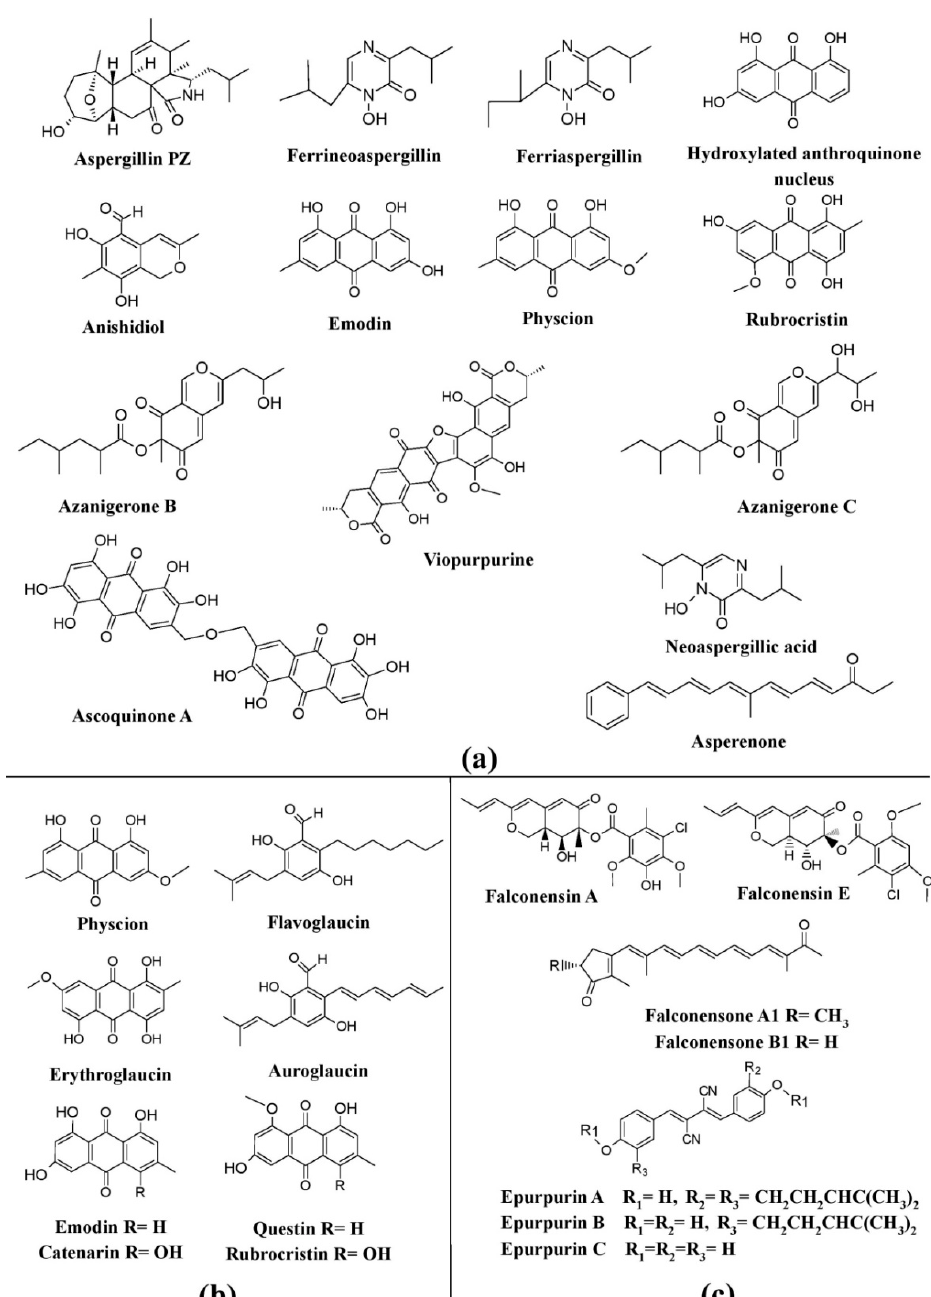
Figure 5. Pigments from the genus Aspergillus and its teleomorphic genera. ( a ) Structures of pigments produced by Aspergillus species. ( b ) Pigments produced by species of Eurotium (teleomorph of Aspergillus ). ( c ) Pigments produced by species of Emericella (teleomorph of Aspergillus ), re-drawn from [25].